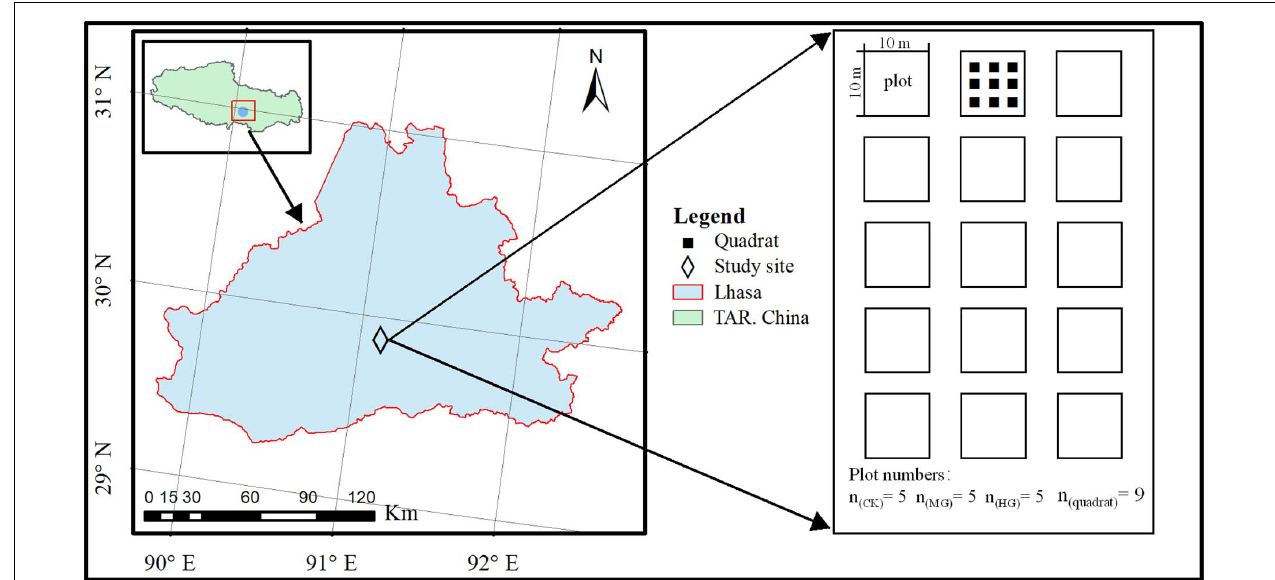
FIGURE 1 | Location of the study site in the Lhasa River Basin and experimental plot design.